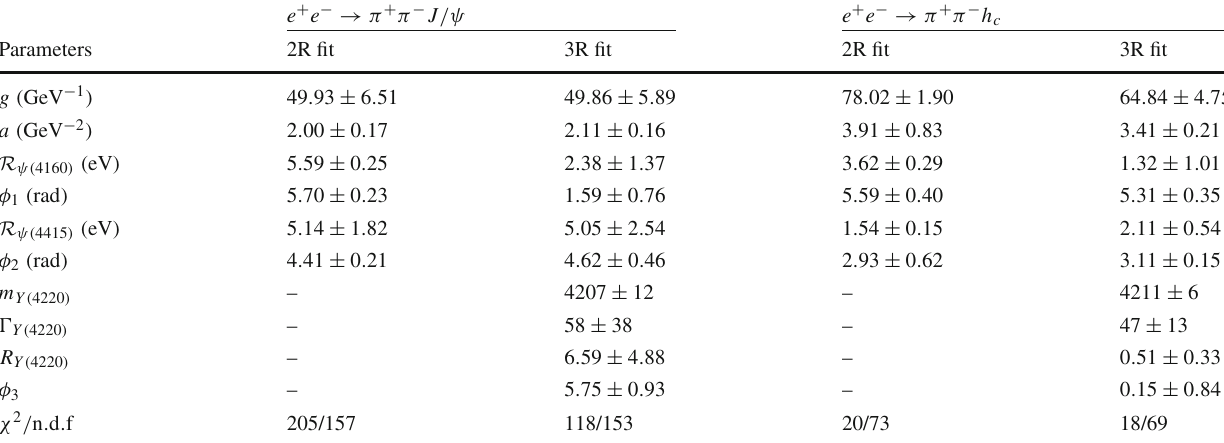
Table 1 The parameters obtained by fitting the cross section for e + e − → π + π − J /ψ [8,12] and e + e − → π + π − h c [9] e + e − → π + π − J /ψ